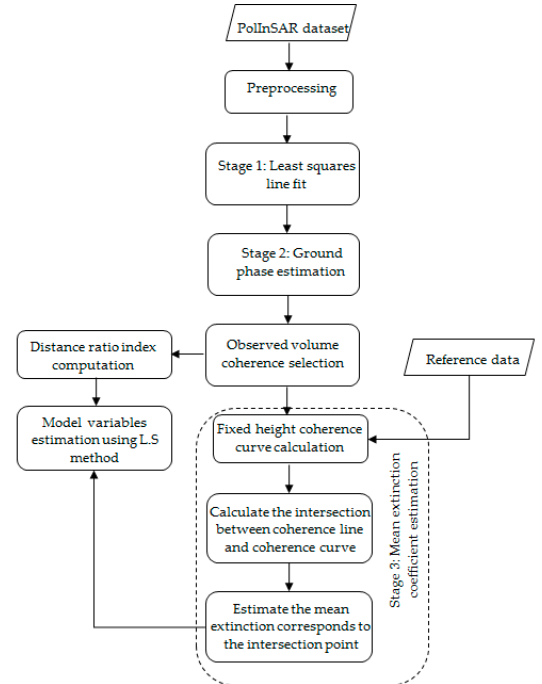
Figure 11. Flowchart for finding the unknown parameters of the linear model.